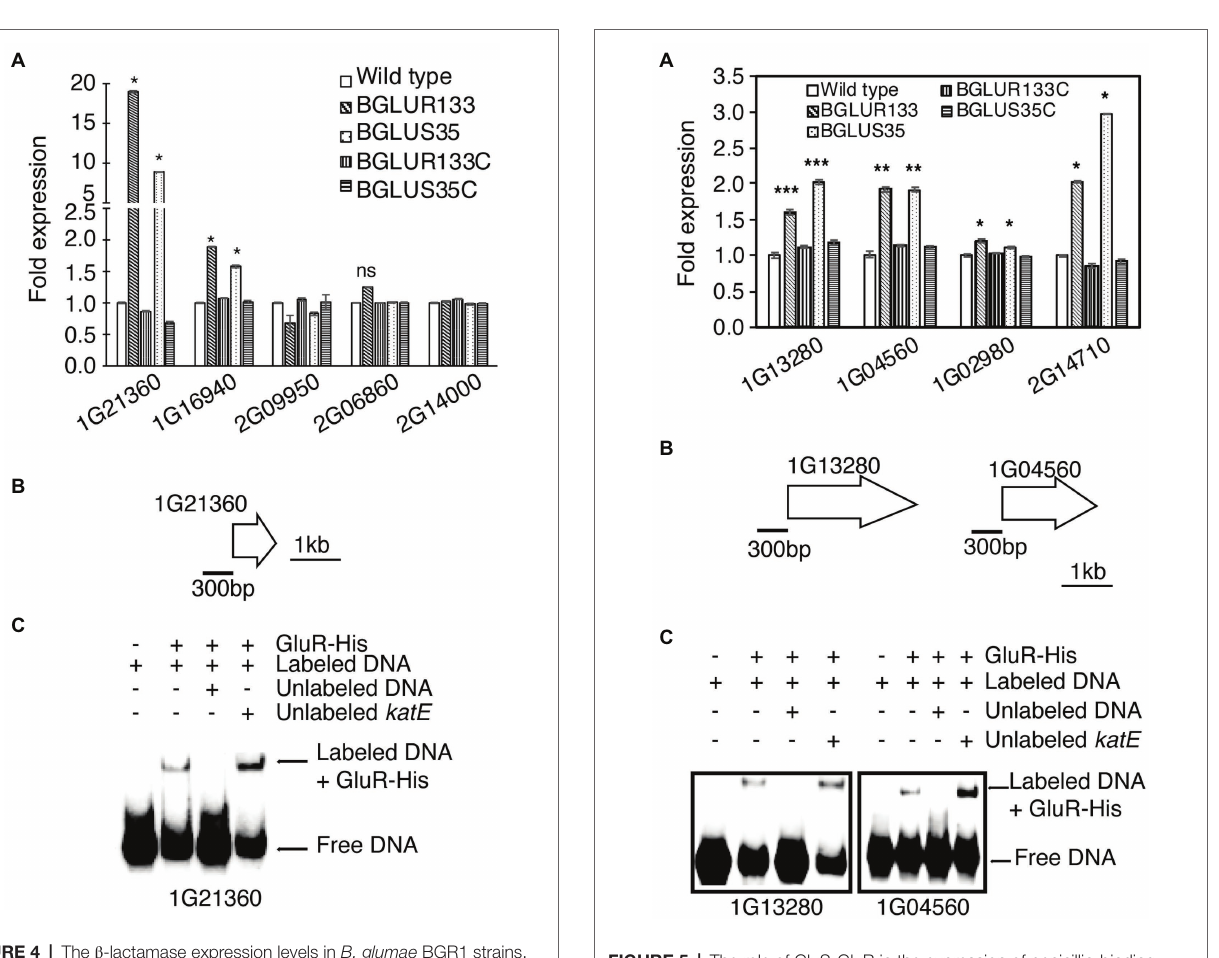
FIGURE 5 | The role of GluS-GluR in the expression of penicillin-binding proteins (PBPs) in B. glumae strains. (A) qRT-PCR analysis of PBP gene expression in the indicated strains. Genes shown in the graph include BGLU_2G14710, BGLU_1G02980 (1A family), BGLU_1G04560 (2A family), and BGLU_1G13280 (membrane carboxypeptidase). Data are mean ± SE of triplicate experiments. Statistical analysis was performed using one-way ANOVA, followed by Tukey’s test for multiple comparisons (*** p < 0.0005; ** p < 0.005; * p < 0.0005; F 19,40 = 1,550.875, p = 0.00). (B) Gene maps showing the putative promoter regions of the selected genes for EMSA. (C) EMSA results showing direct binding of GluR-His to the putative promoter regions of BGLU_1G13280 and BGLU_1G04560; 1 μ M GluR-His, 2 nM labeled target DNA, 2 nM unlabeled katE non-competitor DNA, and 30 nM unlabeled target promoter DNA were used for